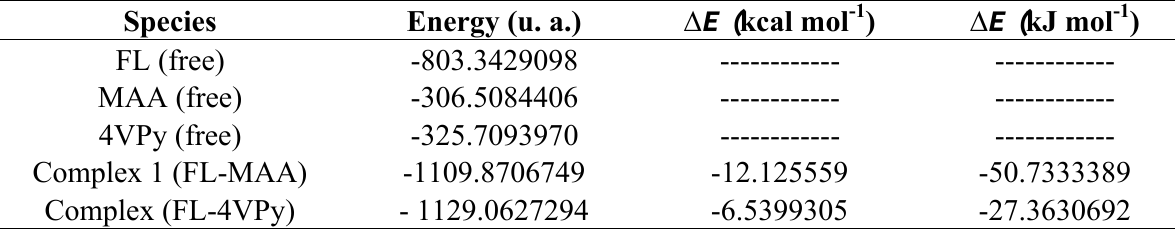
Table 8. Δ E of FL-MAA and FL-4VPy complexes in CHCl solv